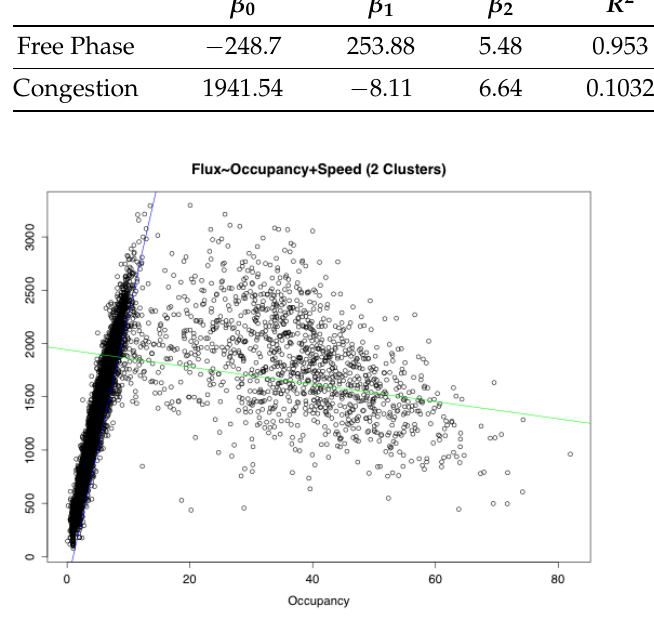
Figure A8. Flux vs. occupancy + speed: RSS analysis. Table A4. RSS analysis with three clusters with flux and occupancy. β 0 is the value of the intercept and β 1 the